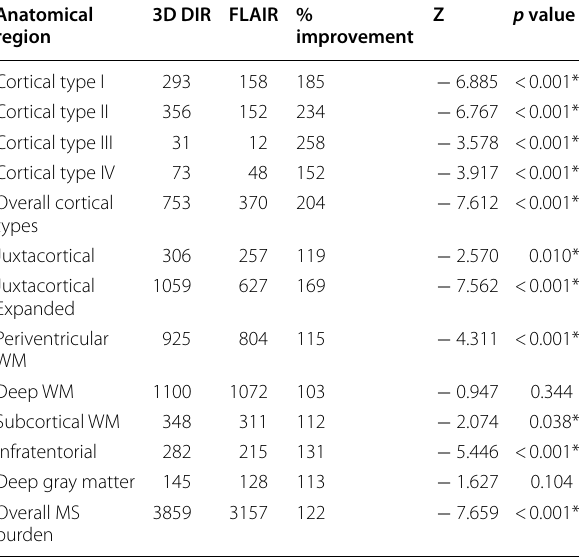
Table 2 MS plaques load in the different anatomical regions